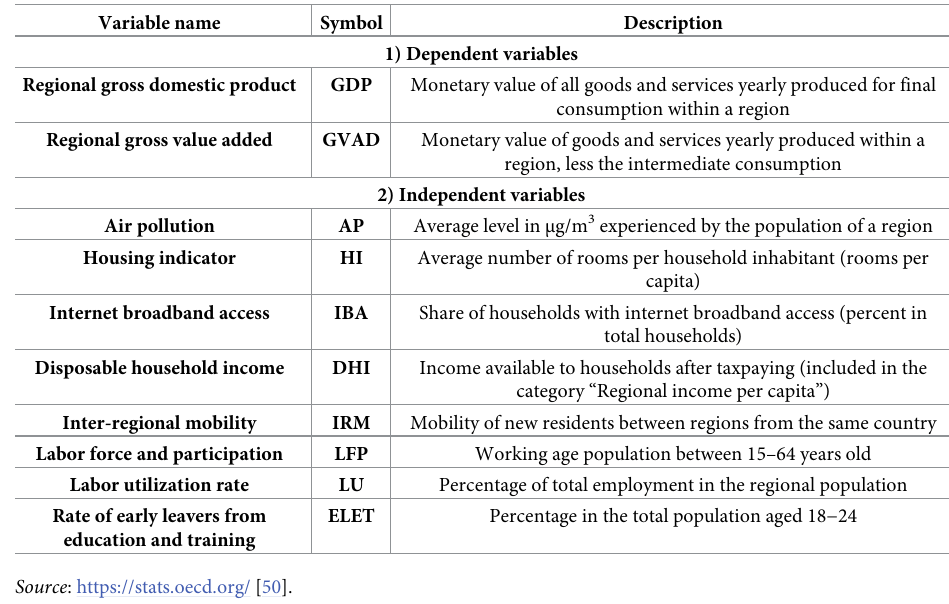
Table 2. Variable symbols and